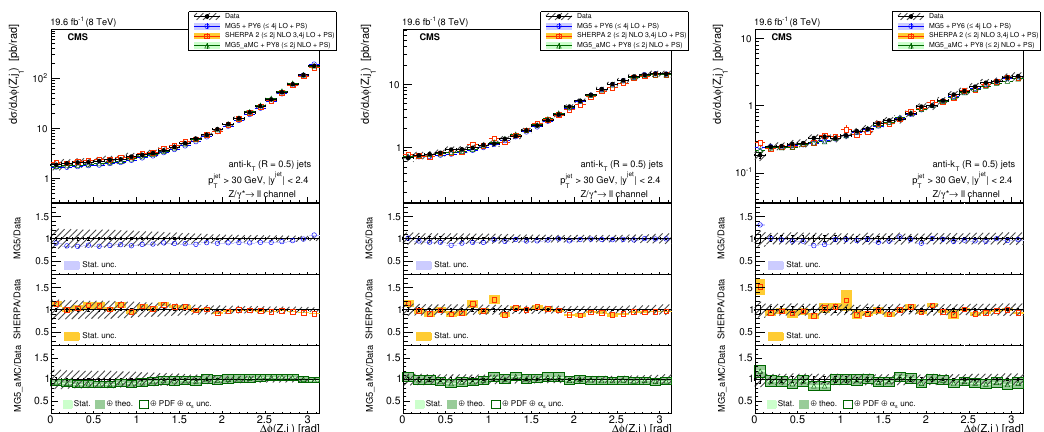
Figure 18 . The di(cid:11)erential cross section as a function of the azimuthal angle between the Z boson and the leading jet for di(cid:11)erent jet multiplicities, (left) N jets (cid:21) 1, (middle) N jets (cid:21) 2, and (right) N jets (cid:21) 3. The lower panels show the ratios of the theoretical predictions to the measurements. Error bars around the experimental points show the statistical uncertainty, while the cross-hatched bands indicate the statistical and systematic uncertainties added in quadrature. The boxes around the mg5 a mc + pythia 8 to measurement ratio represent the uncertainty on the prediction, including statistical, theoretical (from scale variations), and PDF uncertainties. The dark green area represents the statistical and theoretical uncertainties only, while the light green area represents the statistical uncertainty